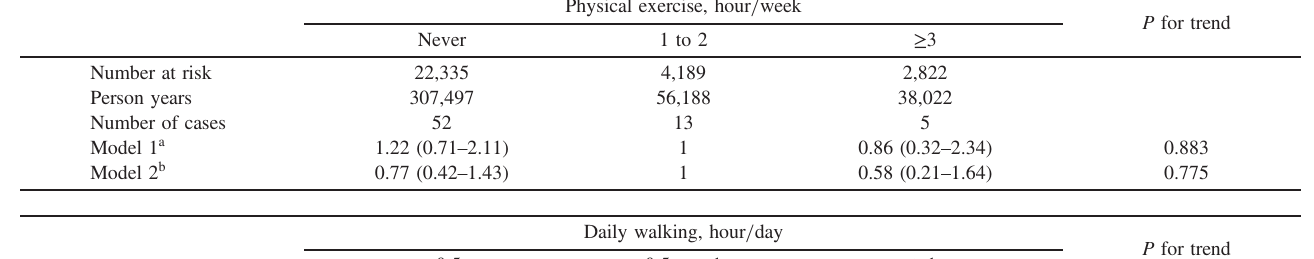
Table 6. Hazard ratios (95% con fi dence intervals) of incident endometrial cancer according to the hours of physical exercise, walking and television viewing Physical exercise, hour =